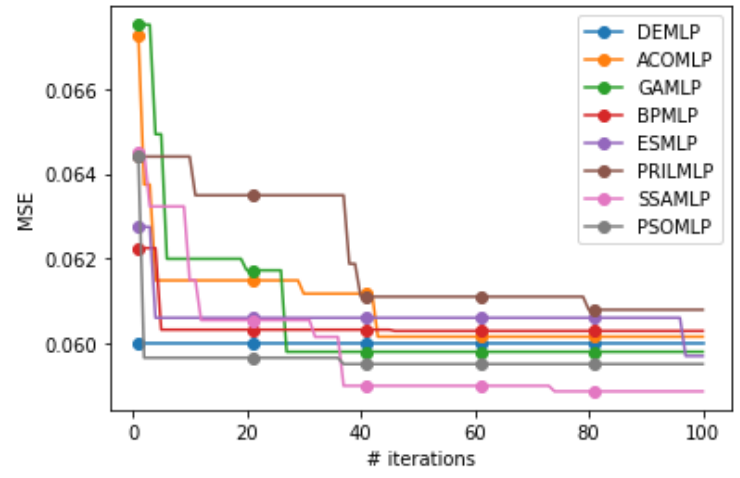
Figure 6. Convergence curves of the proposed SSAMLP and other